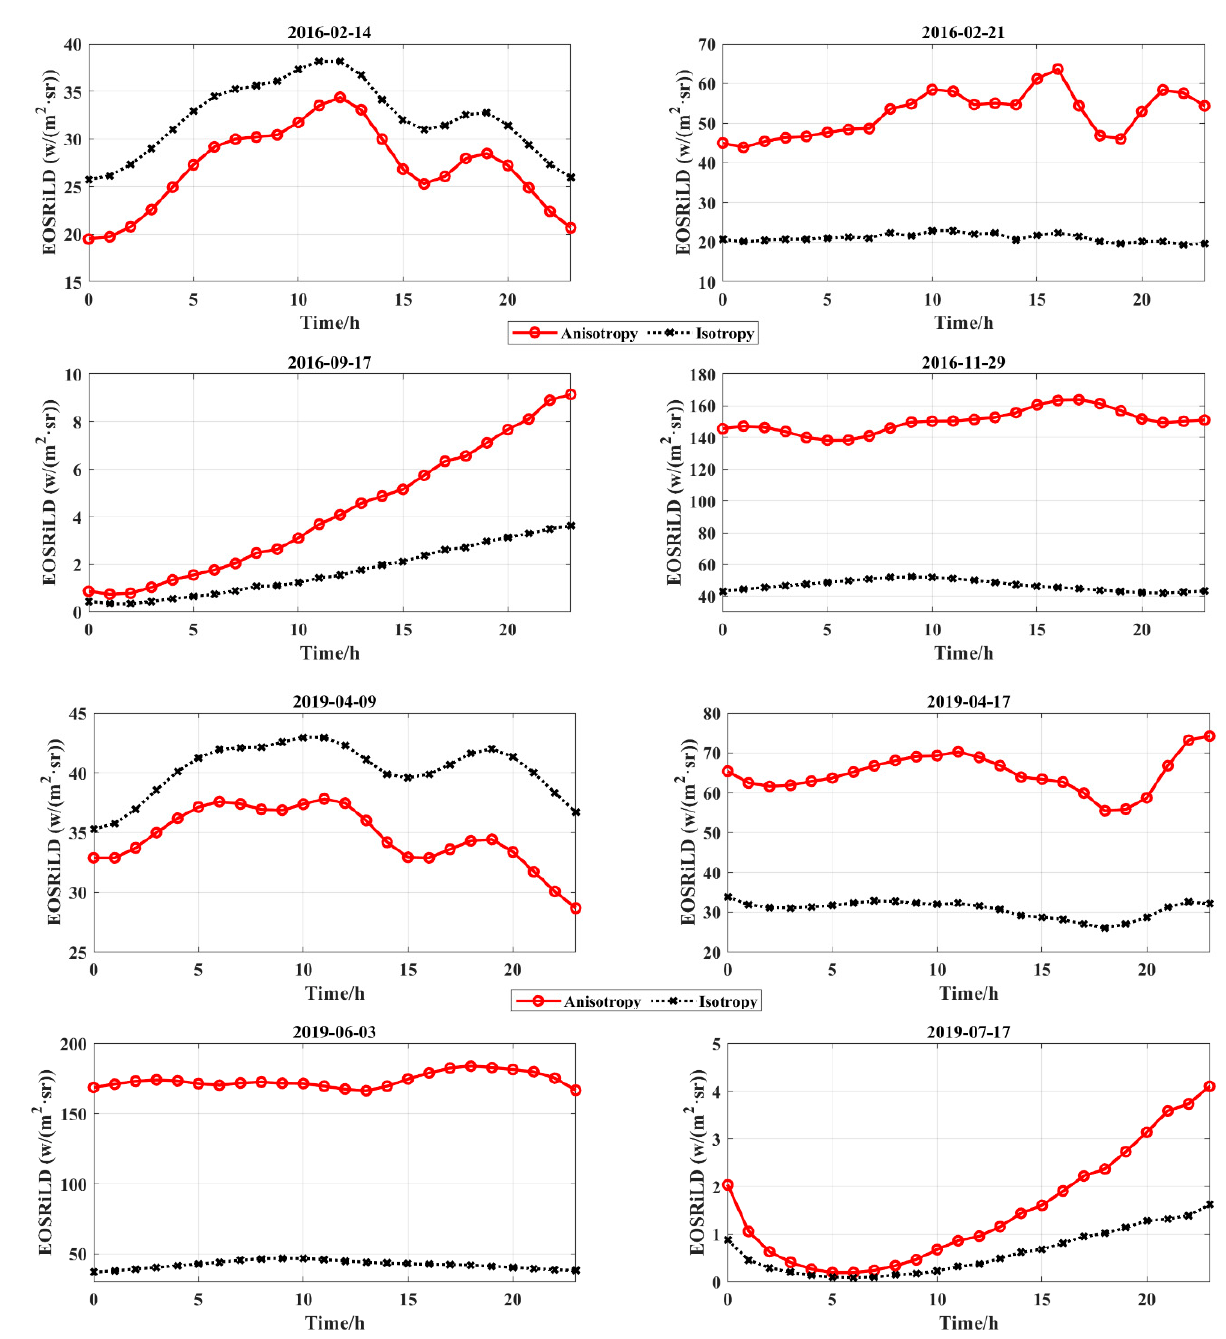
Figure 9. Simulation of hourly EOSRiLD over Earth’s rotation period in 2016 and 2019.